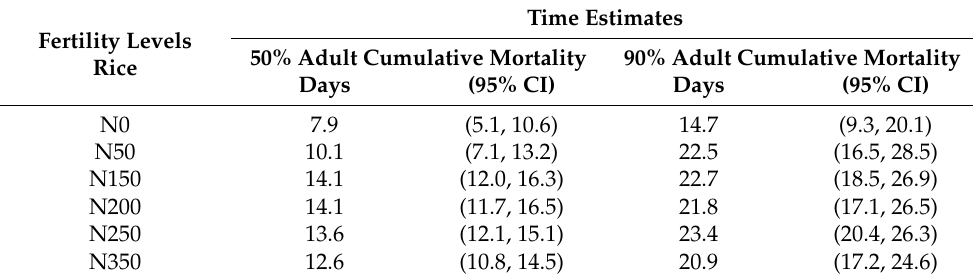
Table 4. Time estimates for 50% and 90% of adult cumulative